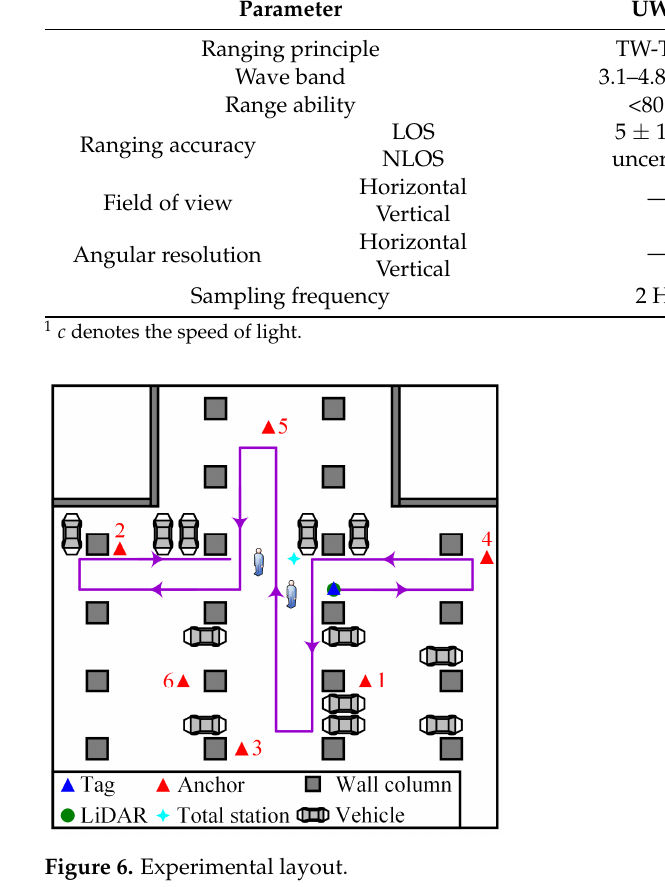
Figure 6. Experimental layout.